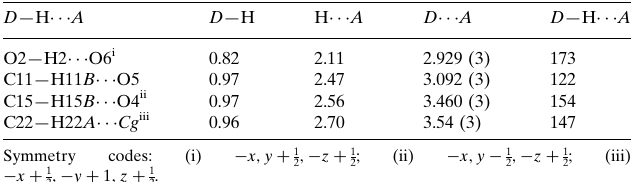
Hydrogen-bond geometry (A˚ , (cid:4) ). Cg is the centroid of the furan